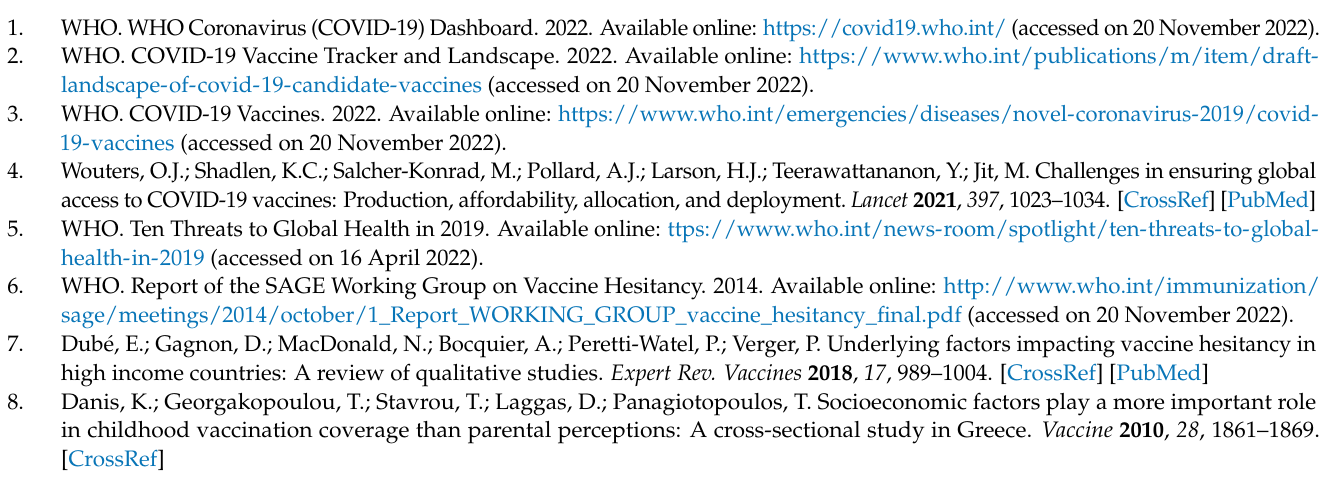
Table S6. Primary sources of media information: Whatsapp. Table S7. Primary sources of media information: